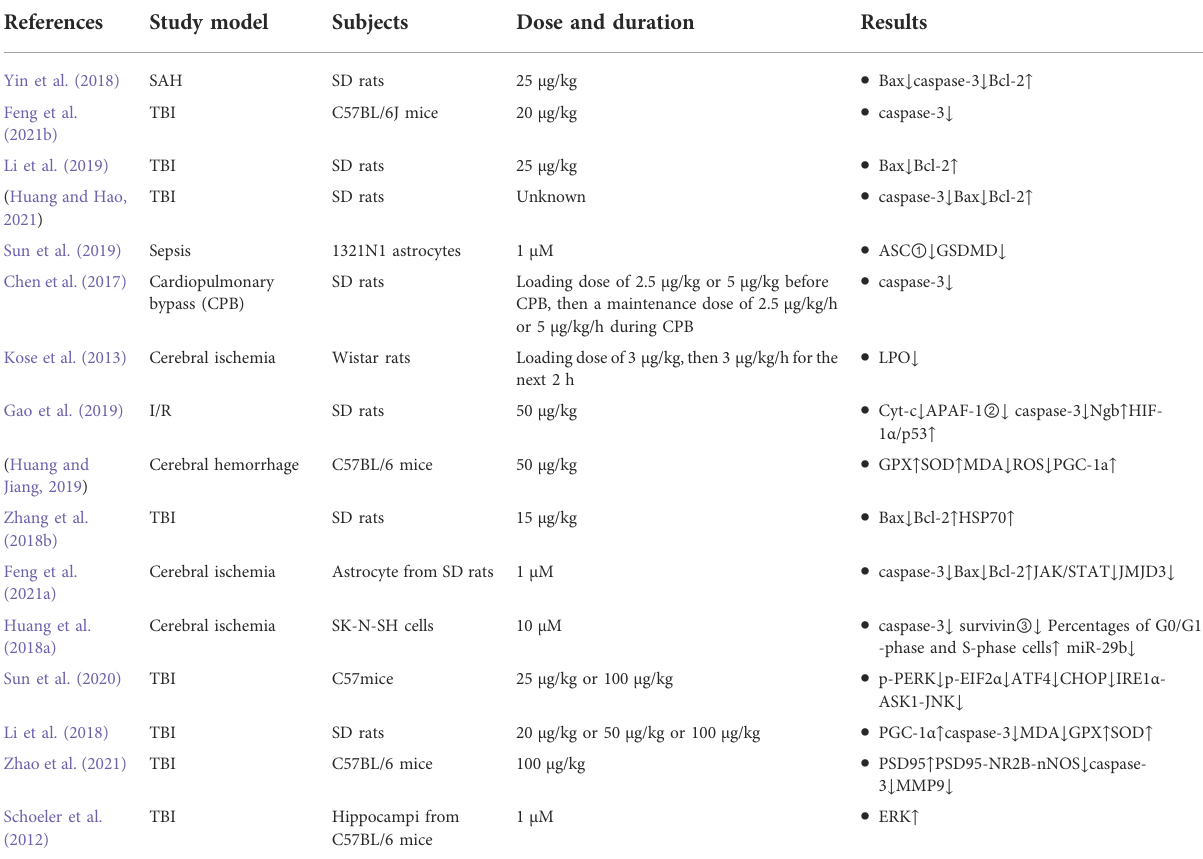
TABLE 2 Changes in various apoptosis-related